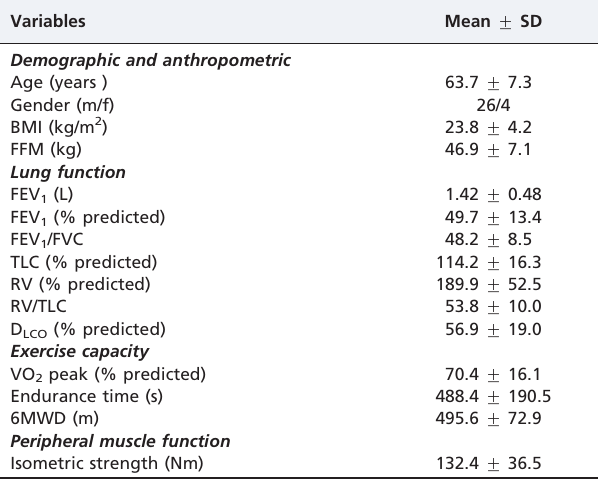
Table 1 - Baseline characteristics (N =